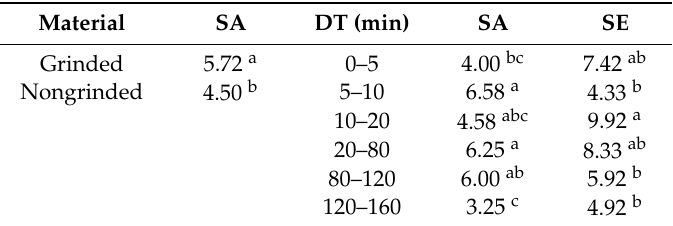
Table 9. Mean values of antimicrobial activity of essential oils against SA obtained from the two Materials, and mean values of antimicrobial activities of essential oil fractions against SA and SE obtained from the 6 Distillation times (DT). DT